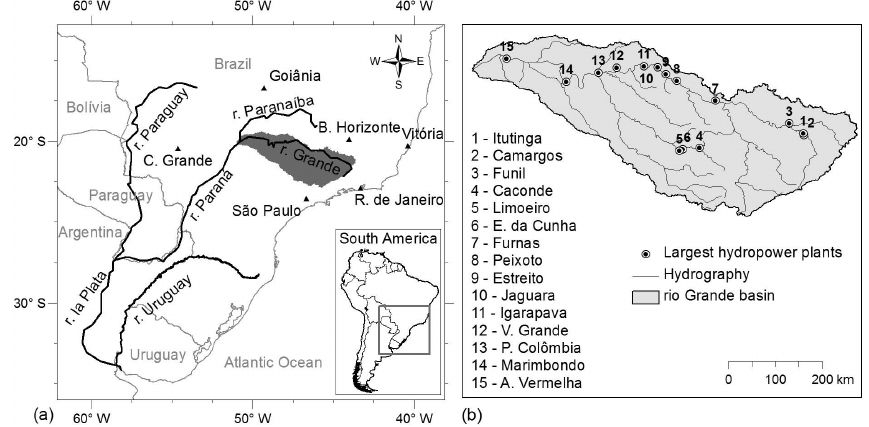
Fig. 1. Maps of (a) regional drainage including the study area (Rio Grande basin) and (b) main hydropower plants in the Rio Grande